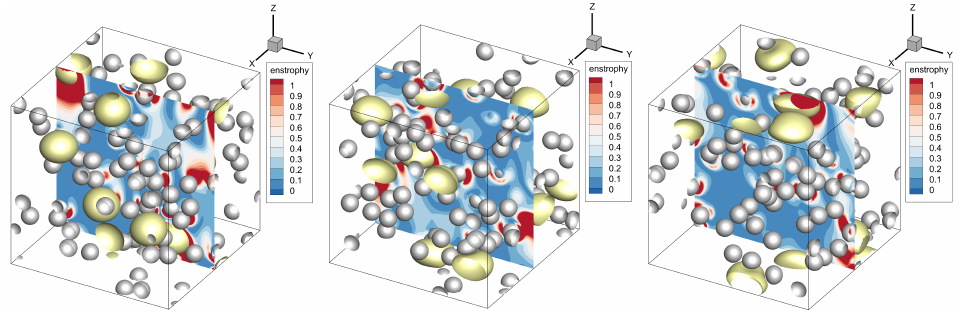
Figure 8. 8 bubbles and 96 drops at time 100, for Eo b = 1.0 ( left ), Eo b = 3.0 ( middle ), and Eo b = 5.0 ( right ). The enstrophy is shown in a plane cutting through the center of the domain.